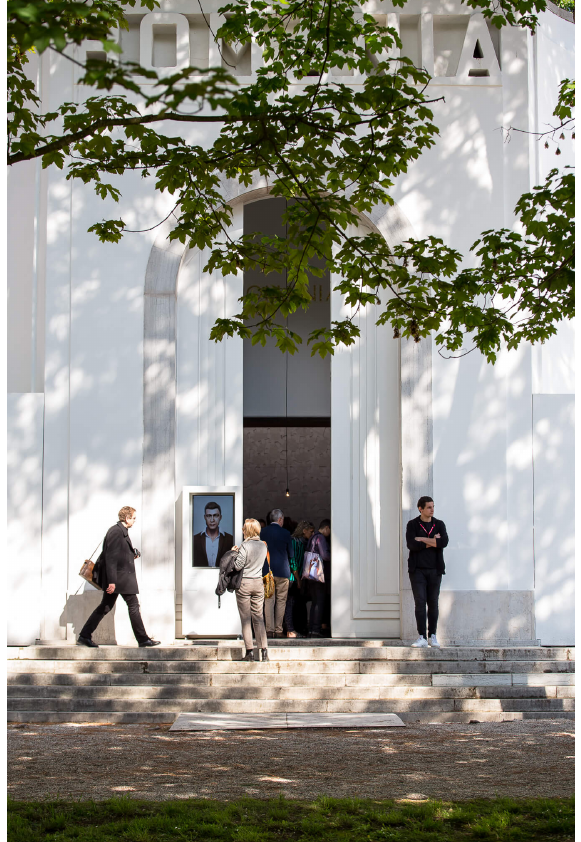
Figure 5. Installation of the system based on Paul Celan at the Romanian Pavilion in the Giardini della Biennale. As seen in this picture, the system had to withstand the Venetian weather and be bright enough to be displayed outside under the sunlight. Source: YAP